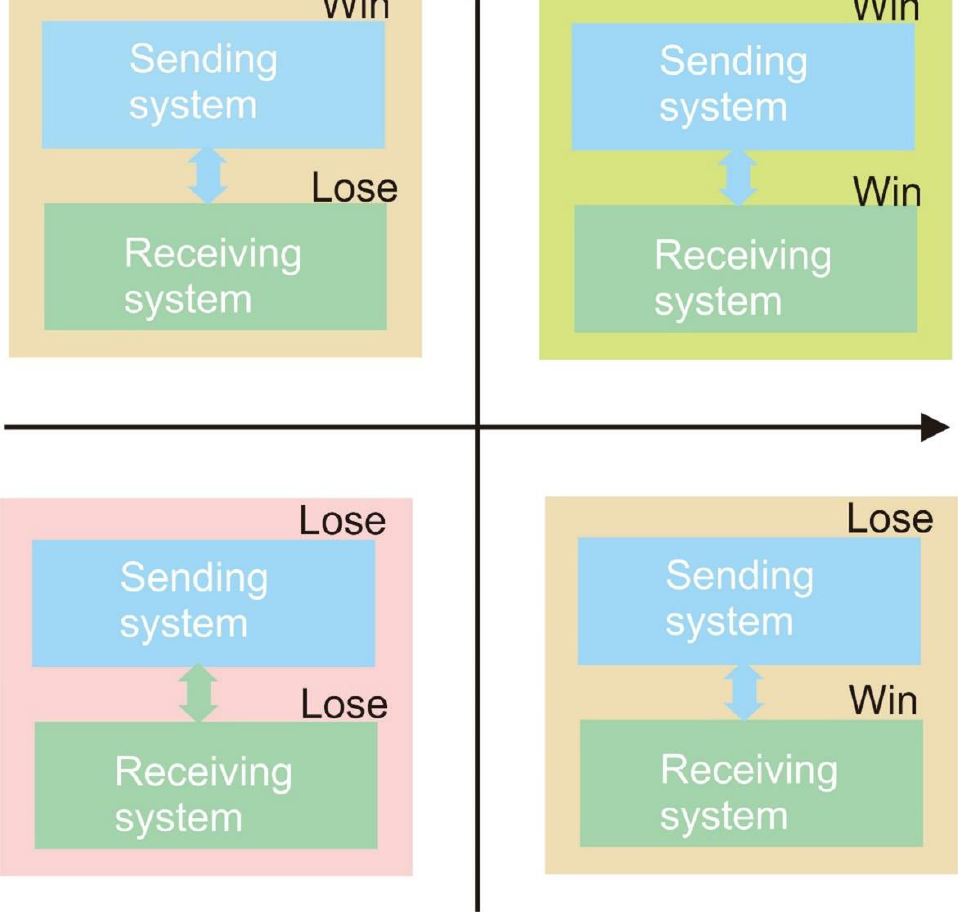
Figure 3. Consequences for the sending and receiving system in a telecoupled system. Notes: the two axes that intersect vertically divide the whole plane into four quadrants: the upper right section is where both sending and receiving system are in the state of “win”, which is the perfect state for systems to pursue; the upper left and lower right part are situations in which one part of the system is in “win” while the other is in “lose”; the lower left part quadrant is the situation when both parts of the telecoupled systems tend to lose in the process.